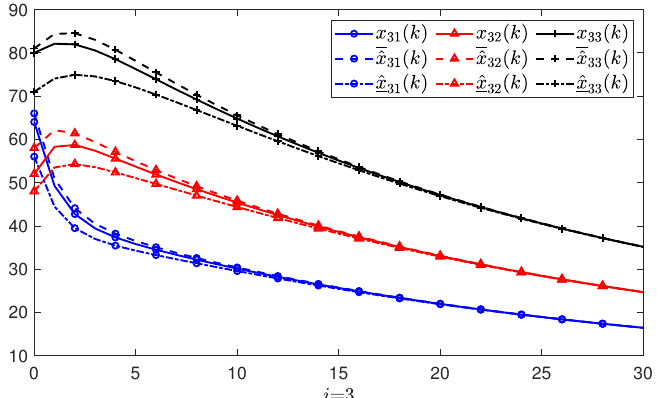
Figure 5. The simulations of all states and their estimations of the 3rd